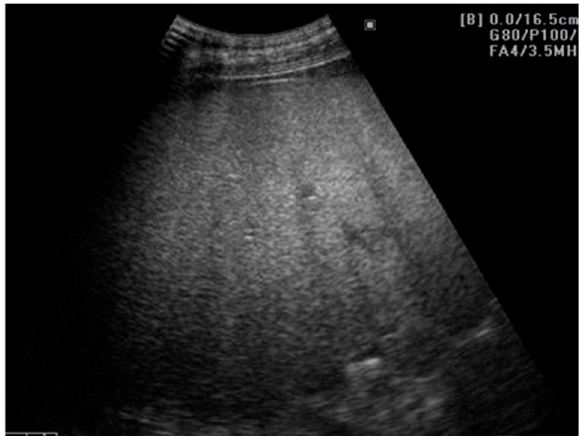
Figure 1. Hepatic steatosis. The 2D-US examination is showing an enlarged liver, with increased echogenicity and posterior beam attenuation, with a slightly inhomogeneous structure of fine granularity, without any FLLs. Even if this aspect is highly suggestive of hepatic steatosis, conventional US is unable to properly quantify the fatty amount of the liver. Also, 2D-US cannot specify whether fibrosis is present or not. Usually, steatosis and fibrosis coexist and therefore “steato-fibrosis” is the preferred term in this situation.